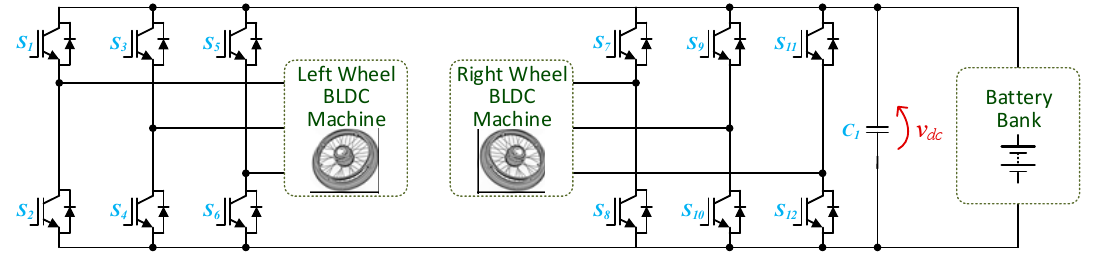
Figure 41. Traction system for an electric wheelchair based on two BLDC machines.